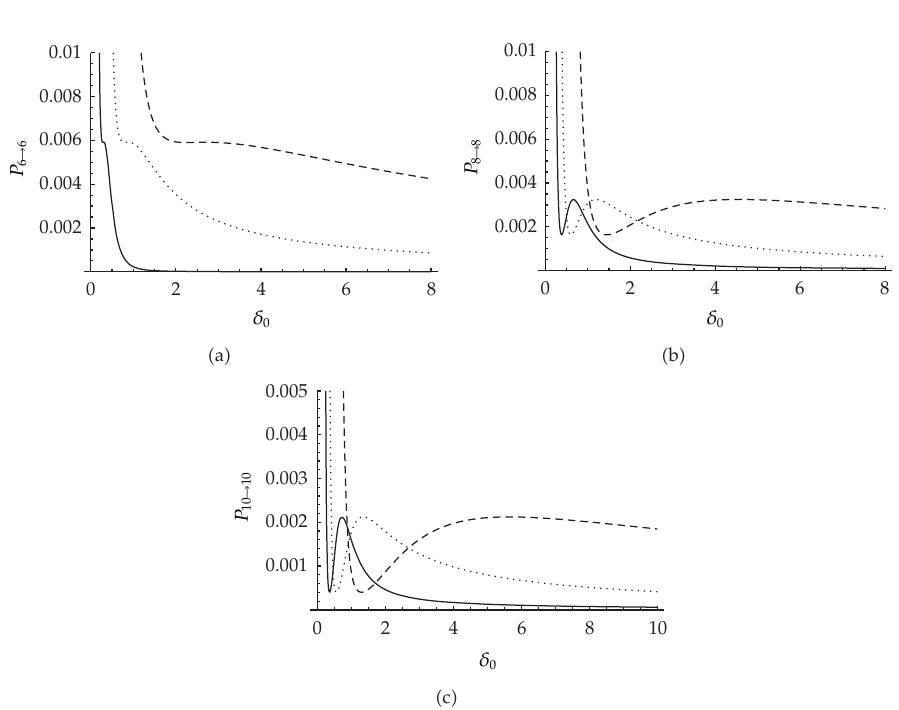
(cid:20) t Figure 3: (cid:4) a (cid:5) : P 6 → 6 versus δ 0 for ω (cid:4) t (cid:5) (cid:5) dt (cid:5) (cid:8) 1 , 2 , 5 (cid:4) solid, dashed, dotted (cid:5) ; (cid:4) b (cid:5) - (cid:4) c (cid:5) P 8 → 8 and P 10 → 10 versus (cid:20) t 0 t δ 0 versus δ 0 for ω (cid:4) t (cid:5) (cid:5) dt (cid:5) (cid:8) 1 , 2 , 3 (cid:4) dashed, dotted, solid (cid:5) . t 0